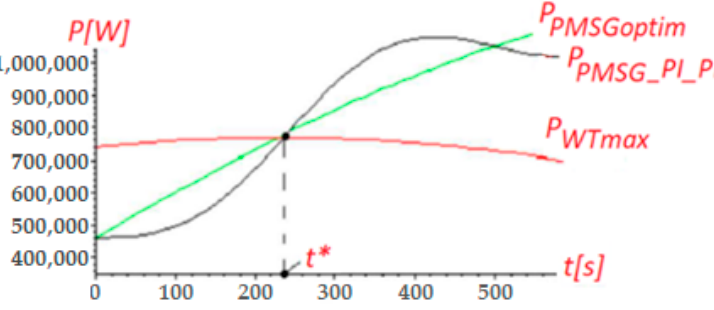
optimal power curve 𝑃 (cid:3017)(cid:3014)(cid:3020)(cid:3008)(cid:3042)(cid:3043)(cid:3047)(cid:3036)(cid:3040) (𝑡) , which result from the kinetic motion equation.